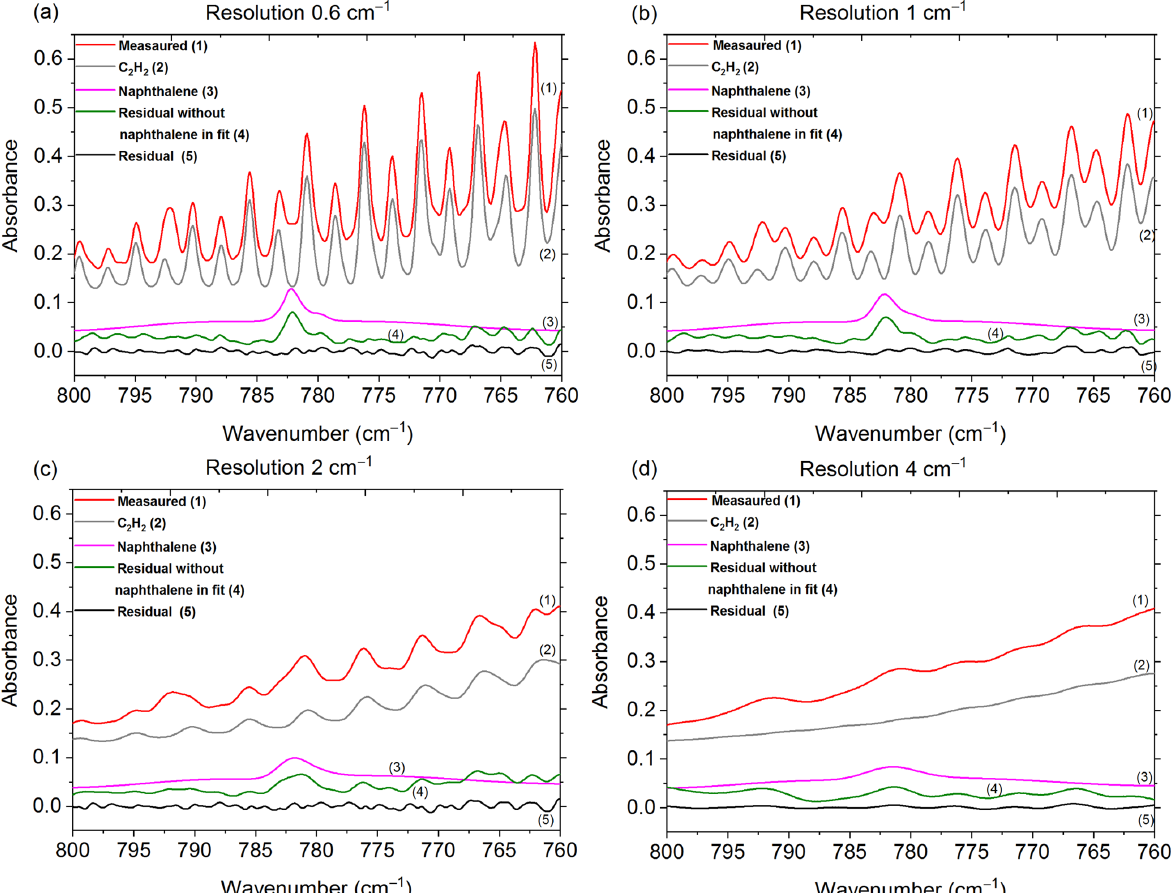
Figure 2. Measured and scaled reference spectra for C 2 H 2 and naphthalene, and corresponding residuals with and without naphthalene included in the fit for the (a) original spectrum collected at 0.6cm − 1 and the de-resolved spectra at (b) 1cm − 1 , (c) 2cm − 1 and (d) 4cm − 1 . The reference spectra for CO 2 , HCN and H 2 O are not shown (HCN was not included in the fit when the resolution was 4cm − 1 ; for resolutions 1, 2 and 4cm − 1 , H 2 O was not included in the fit when naphthalene was removed from the fit). Spectra are offset for